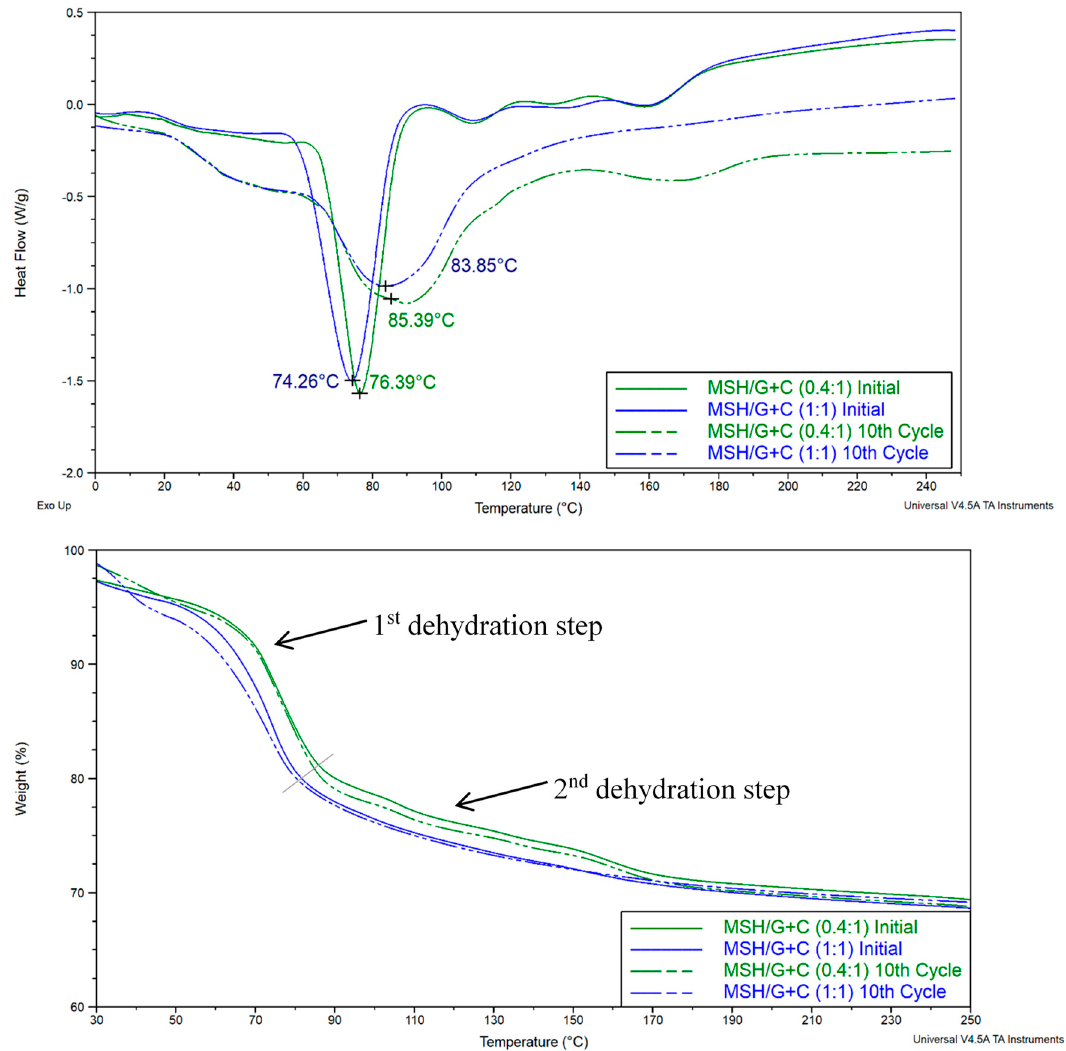
Figure 19. DSC ( top ) and TGA ( bottom ) charts of the MSH/G+C pellets prepared under 5.2 kN/mm − 2 .